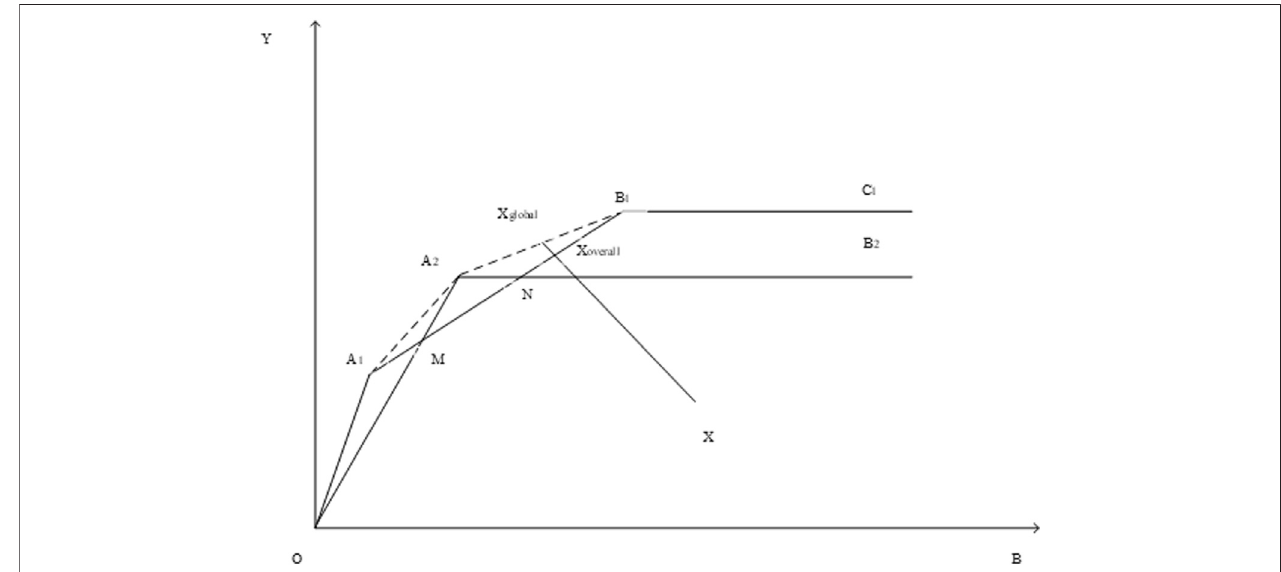
FIGURE 2 | Global PPS and overall